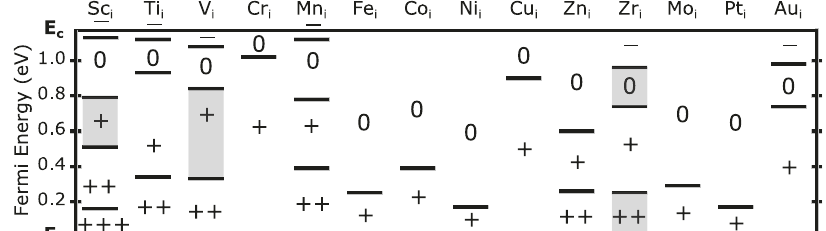
Fig. 4 Thermodynamics charge transition levels for tetrahedral interstitial defects of transition metals. Semi-transparent gray areas highlight the Fermi energy range for the fi nal candidates with triplet – triplet optical transitions within the Si band gap to be stable. 0, + , and − signs indicate the dominant charge state within the Fermi energy